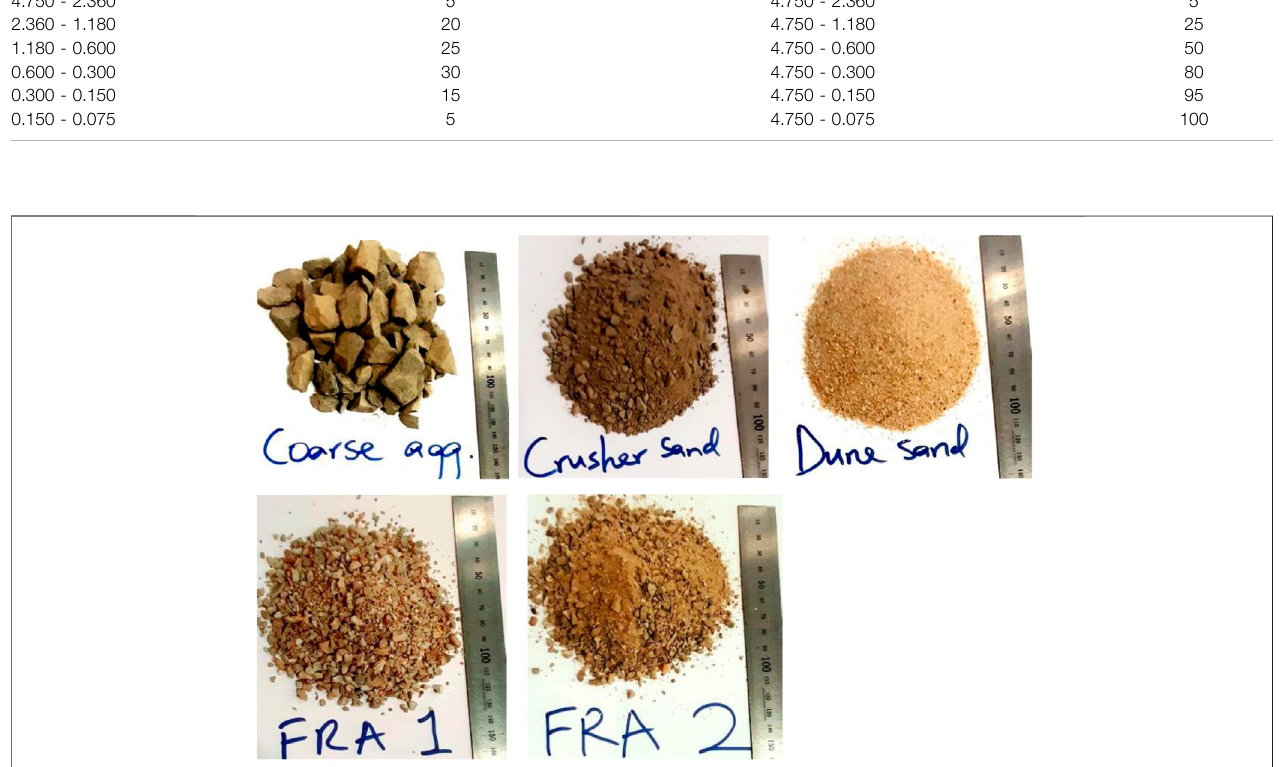
FIGURE 1 | Aggregates used for the study.